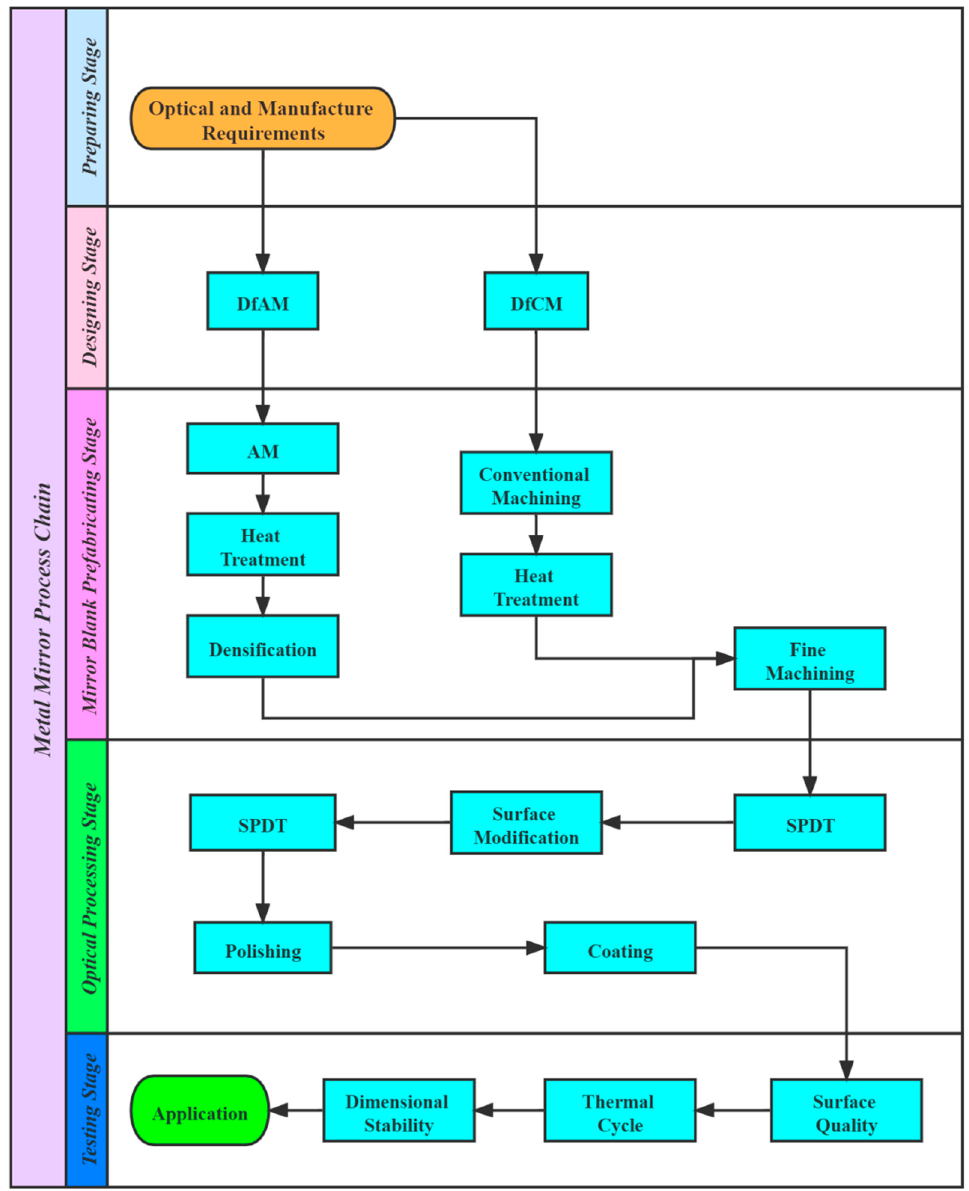
Figure 4. Metal mirrors process chain.